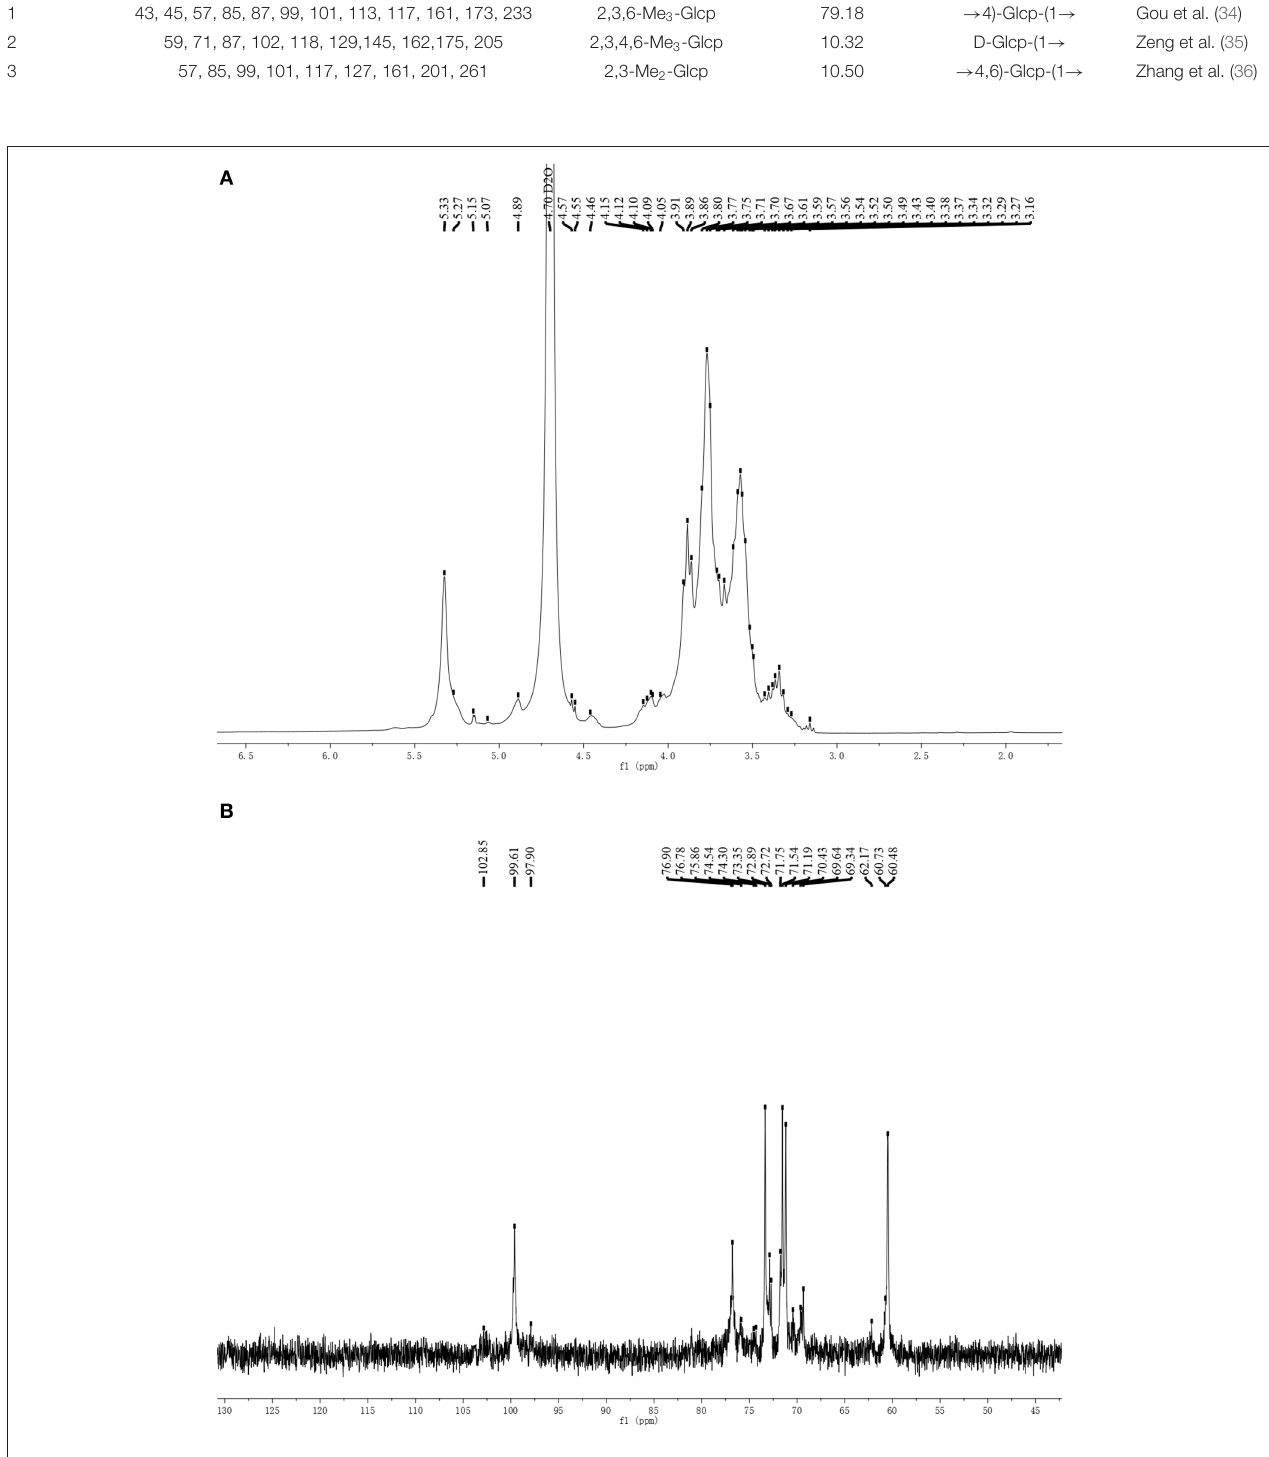
FIGURE 3 | The 1 H-NMR spectrum (A) and 13 C-NMR spectrum (B) of PSP-1.